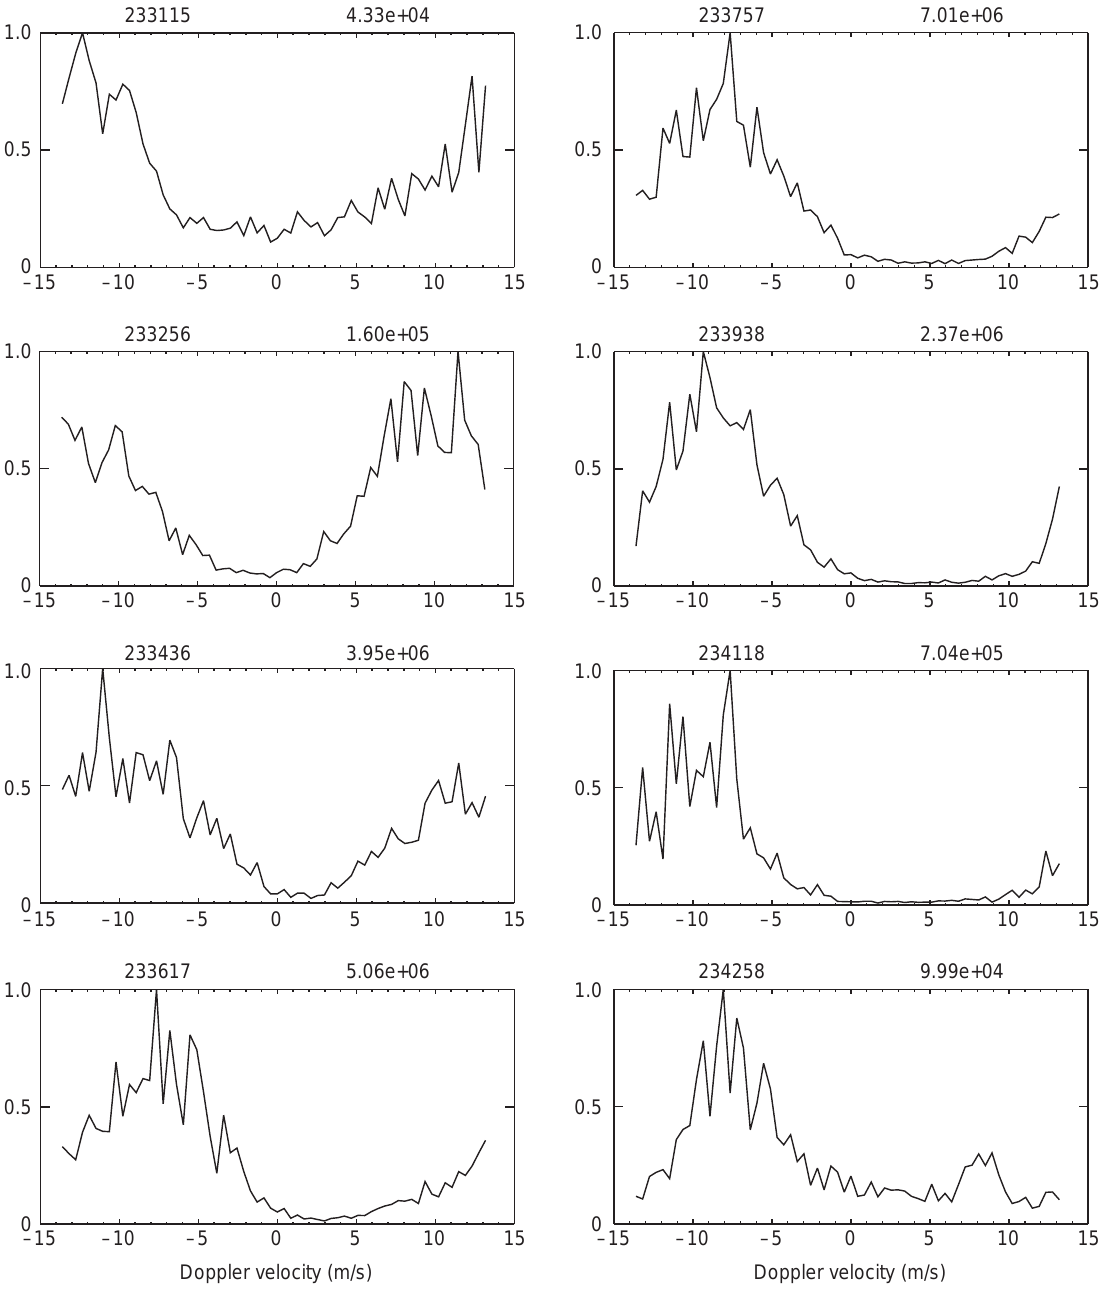
Fig. 4. Sequence of backscatter spectra recorded with the vertically pointing beam of the ALOMAR SOUSY radar averaged over ten height gates from 98.6–101.3 km. Above each subplot the time and